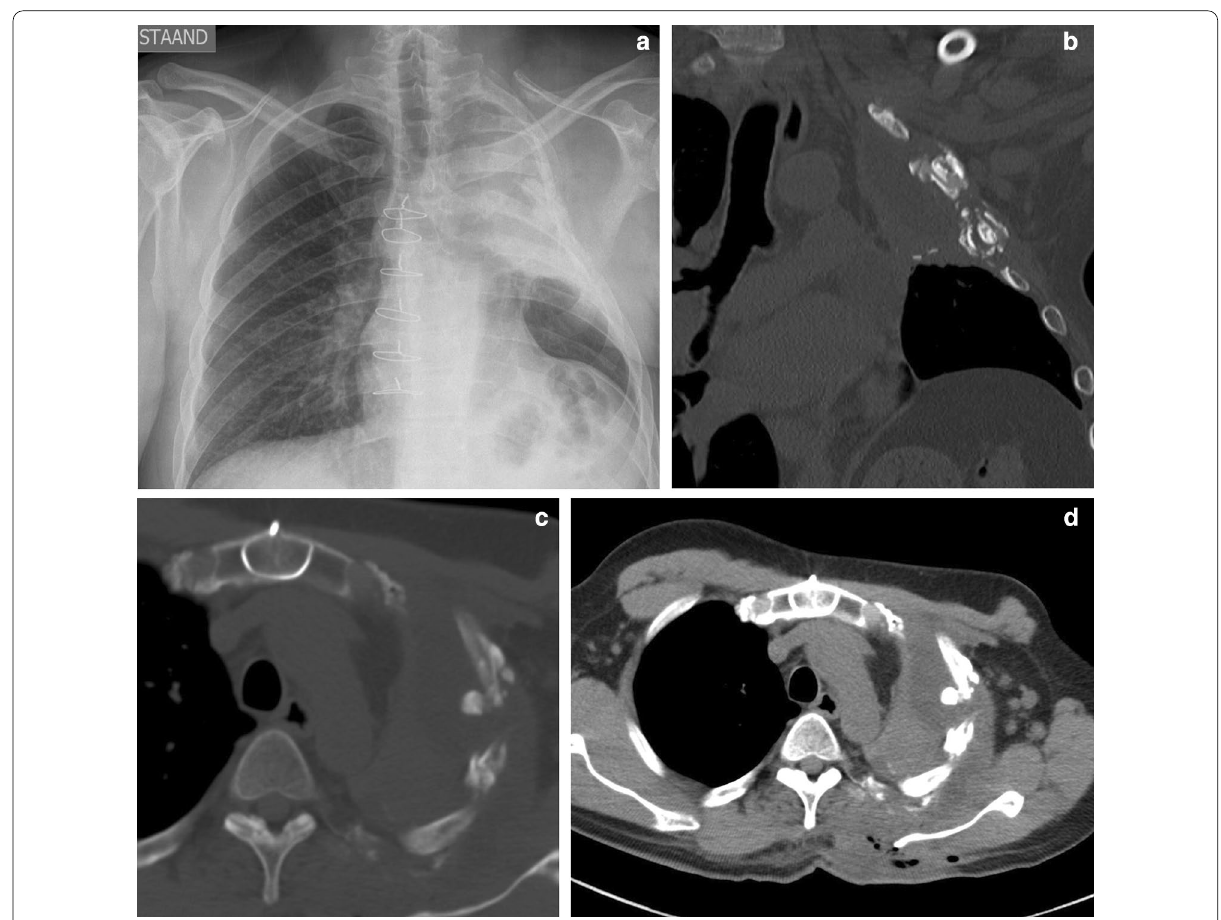
Fig. 18 Diagnosis: radio-osteonecrosis and/or osteomyelitis. Technique: standard chest radiography and contrast-enhanced chest CT. Description: A 43-year-old man presented with left-sided chest pain. His medical history includes a lobectomy of the left upper lobe and radiotherapy. The postero-anterior chest radiograph ( a ) shows deformity and volume loss of the left hemithorax with a dense aspect of the lobectomy space. The coronal and axial CT thorax in bone window ( b , c ) reveals extensive periosteal reaction of the left ribs with inhomogeneous osteosclerosis and necrotic bone (with a typical denser aspect). The mediastinal window setting ( d ) is better to evaluate the adjacent soft tissue component and the fluid in the lobectomy